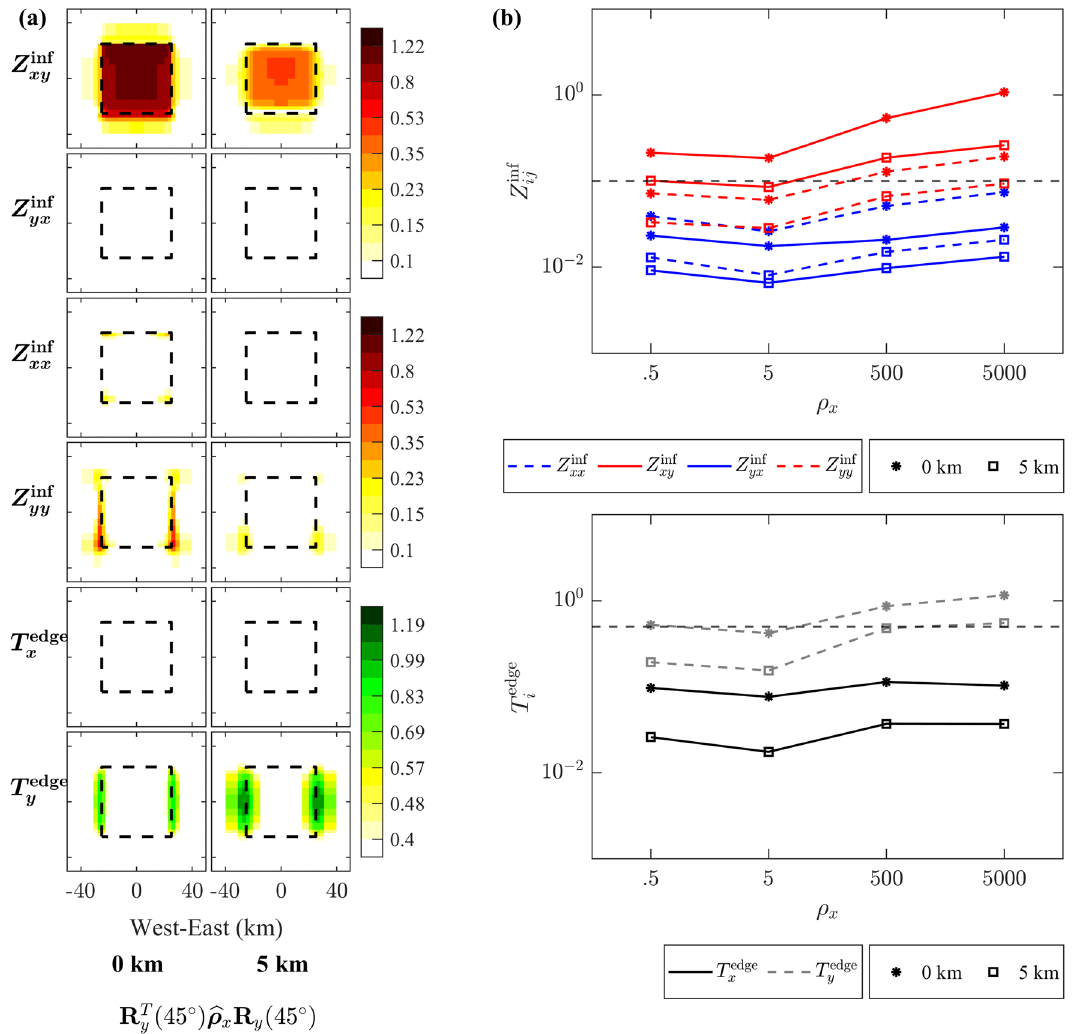
500 0 0 0 50 0 ρ x =  . b Logarithmic plots of Z inf xx , Z inf yy , Z inf xy , Z inf yx , T edge x , and T edge y with  0 0 50   �